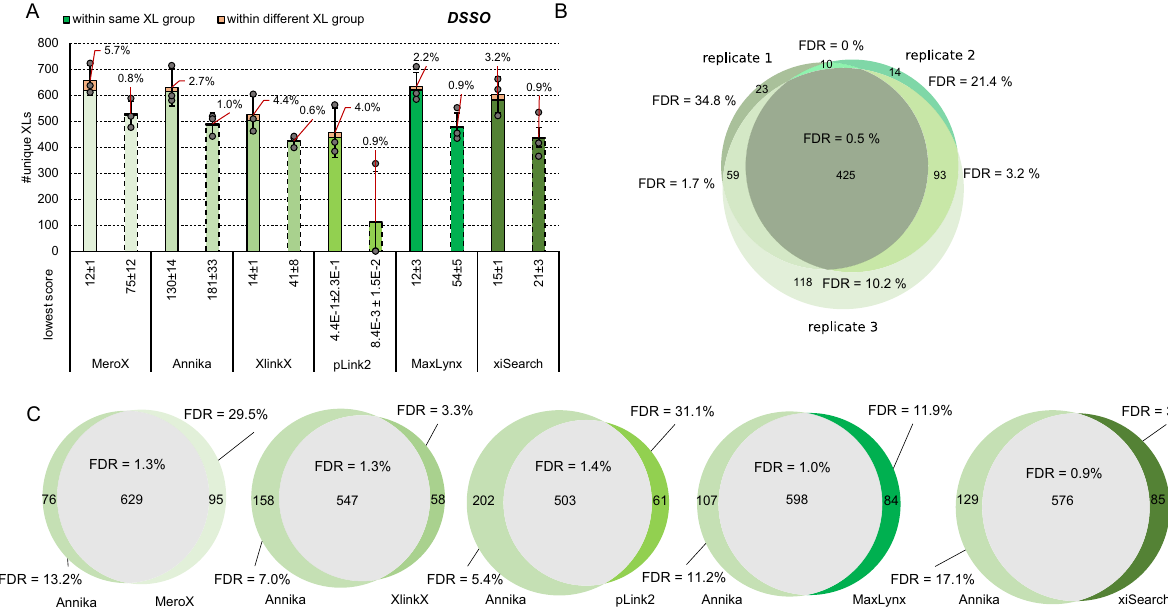
Fig. 2 Benchmarking of data analysis tools on the example of DSSO. A Average crosslink numbers using DSSO after acquisition using a stepped HCD MS2 method. Applied to the main library using the algorithms MeroX 26 , MS Annika 24 , XlinkX 27 , pLink 2 28 , MaxLynx 25 or xiSearch 36, 44 for analysis. All results were obtained at 1% estimated FDR (solid line bars) and corrected by applying a post-score cutoff to reach an experimentally validated FDR < = 1 (dashed line bars). The experimentally validated FDR is shown as callout, error-bars indicate standard deviations of average values, n = 3 independent samples acquired on different days. B Overlap of crosslinks identi fi ed in each replicate using MS Annika. C Overlap of cross links identi fi ed in replicate 3 after analysis using MS Annika or an alternative algorithm as given. B , C : Experimentally validated FDRs for commonly found and exclusively found links are given. Source data are provided as a Source Data fi